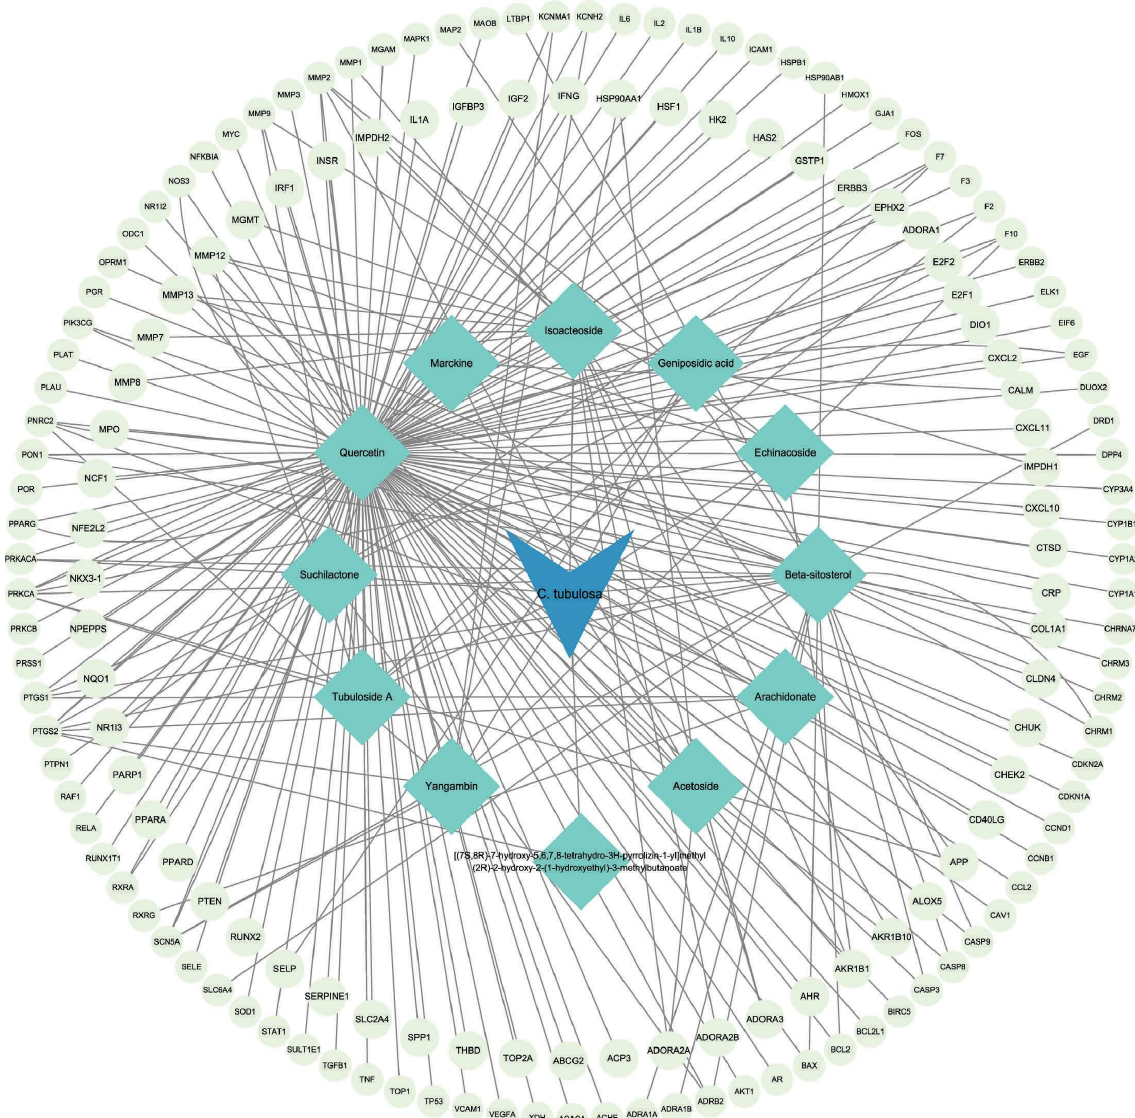
Figure 9: C-T network. Te network showed the correlation between active components and the key gene